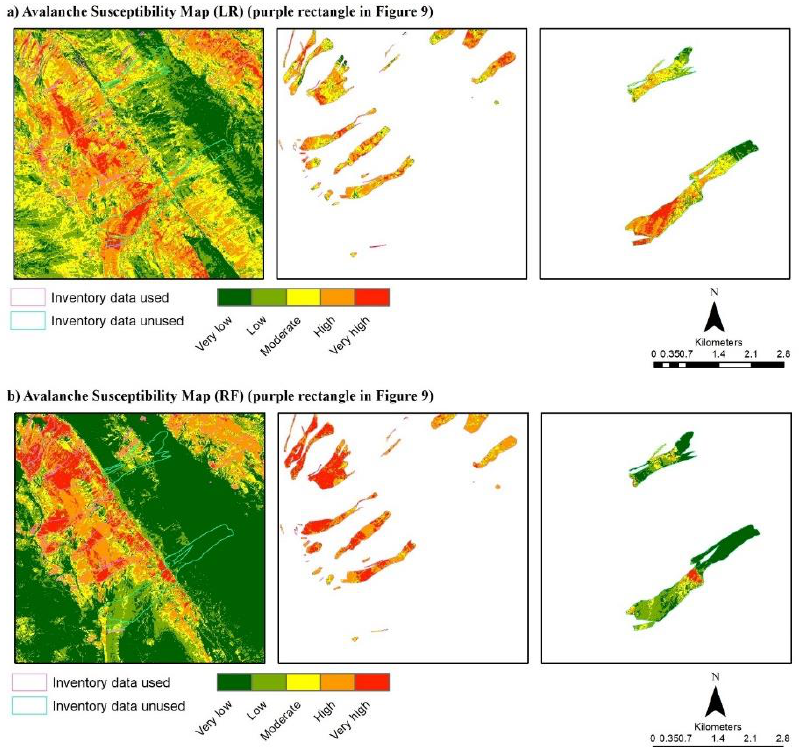
Figure 9. The LR (a) and RF (b) results in a part of the study area (purple rectangle in Figure 9). The two avalanche polygons shown on the right column were not employed in model